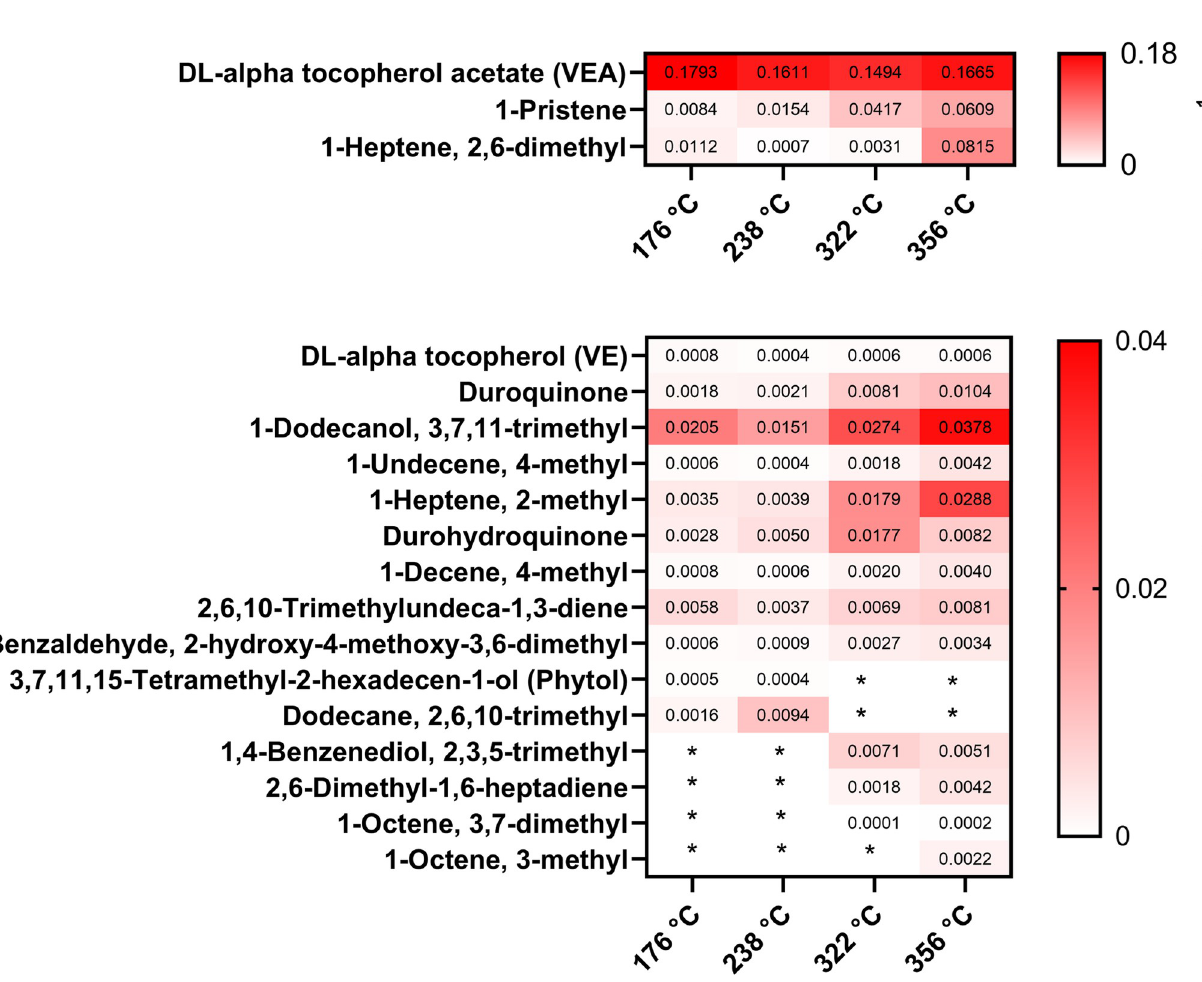
PLOS ONE | https://doi.org/10.1371/journal.pone.0265365 March 24,